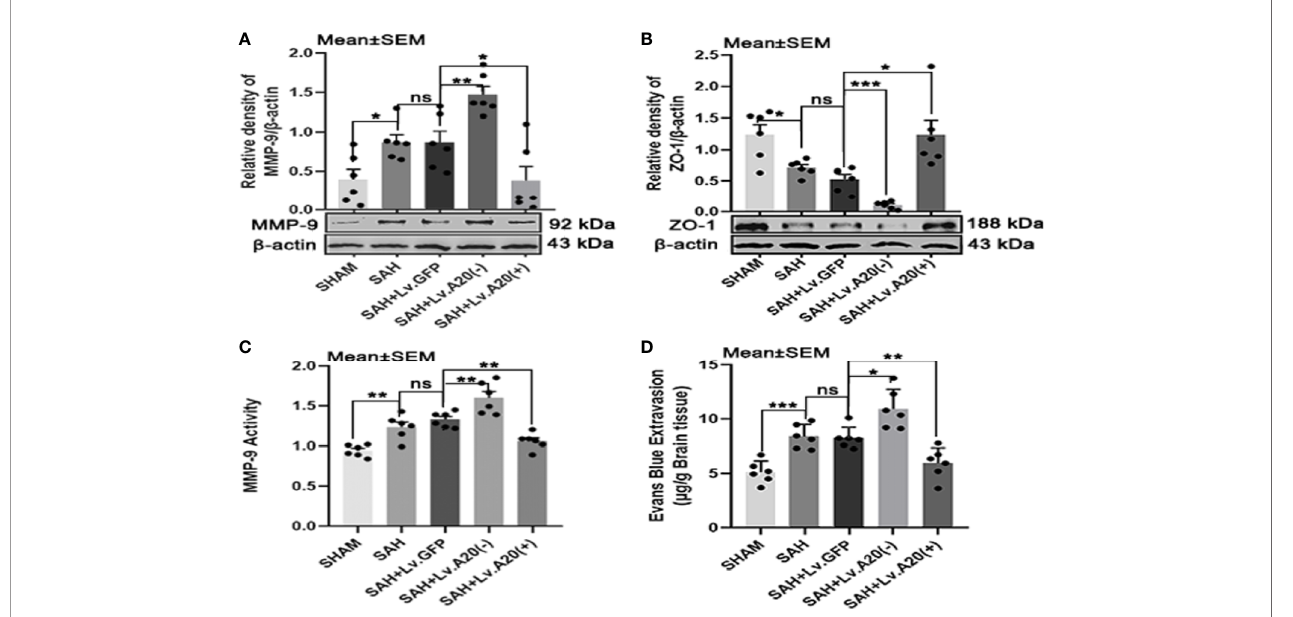
FIGURE 5 | A20 affects MMP-9 and ZO-1 and maintains the integrity of the BBB after SAH. (A, B) Lentivirus transfection for A20 expression affected the expression of MMP-9 and ZO-1 as revealed by representative western blots. (C) A20 expression affected the activity of MMP-9 as revealed by ELISA. (D) Evaluation of the integrity of the BBB by injection of Evans blue dye. A20 played a role in maintaining the integrity of the BBB after SAH. Data are expressed as mean ± SEM, n = 6, * p < 0.05, ** p < 0.01, *** p < 0.005, ns versus SAH. ns, non-signi fi cant.